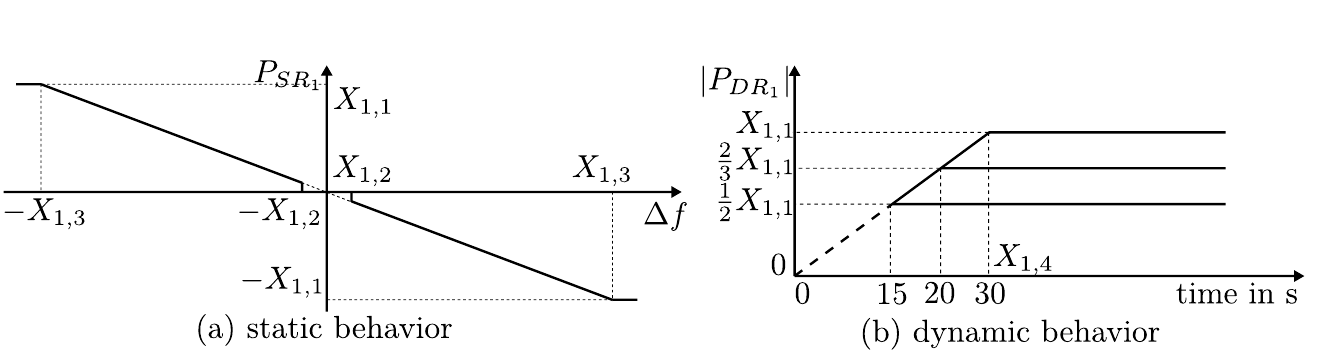
Figure 5. Static- and dynamic behavior of